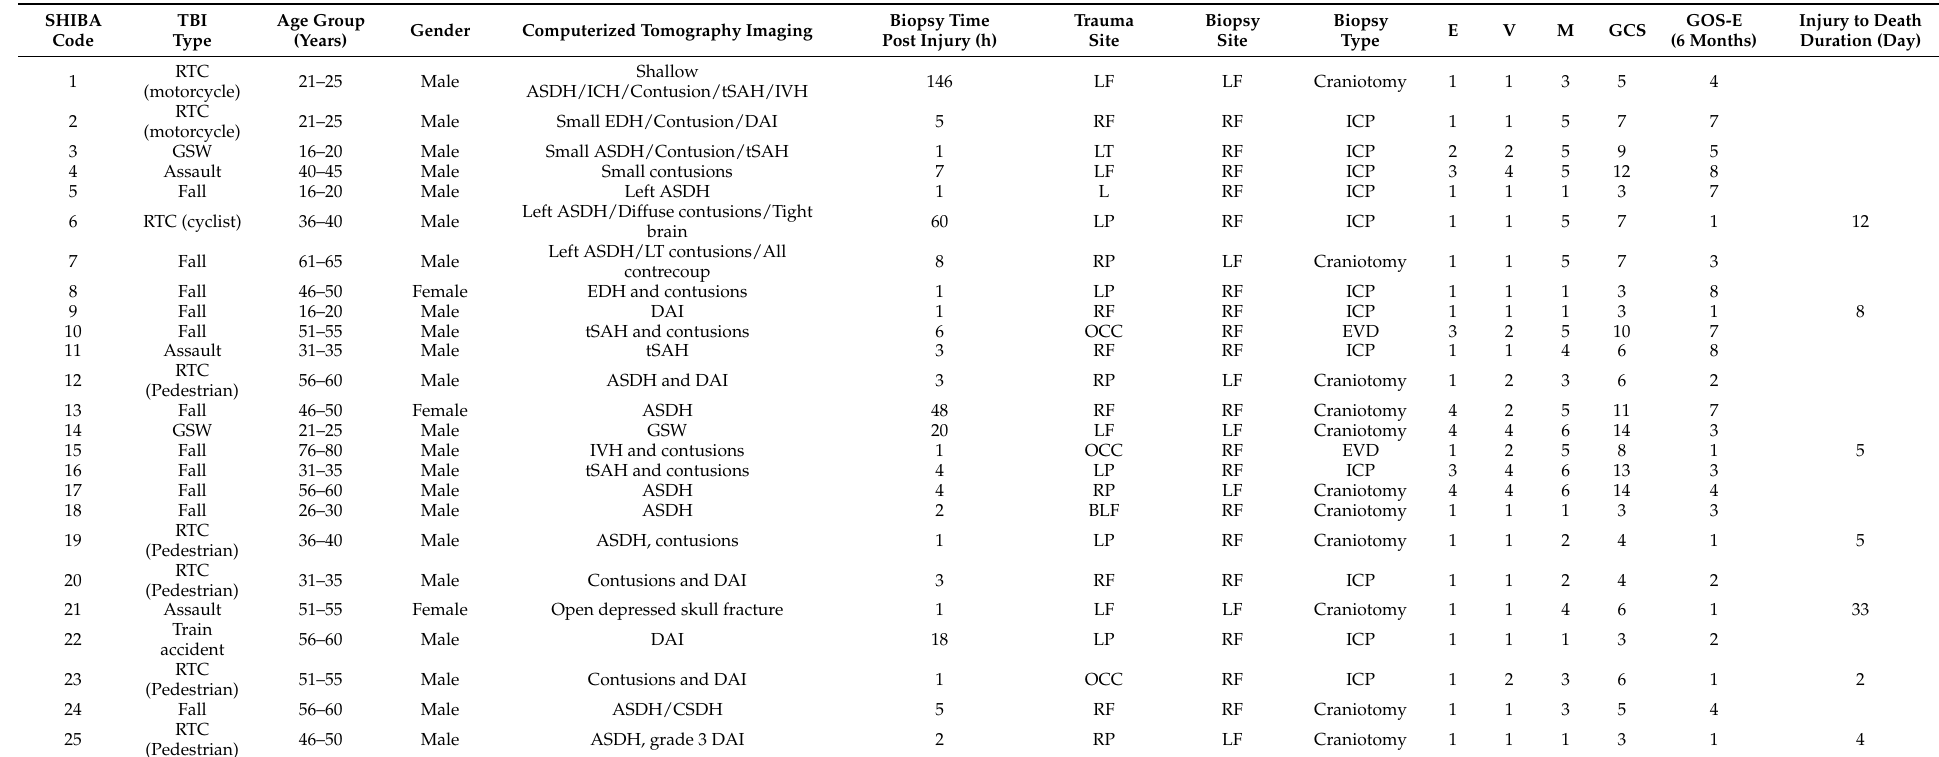
Table 1. Summary clinical details of patients in this